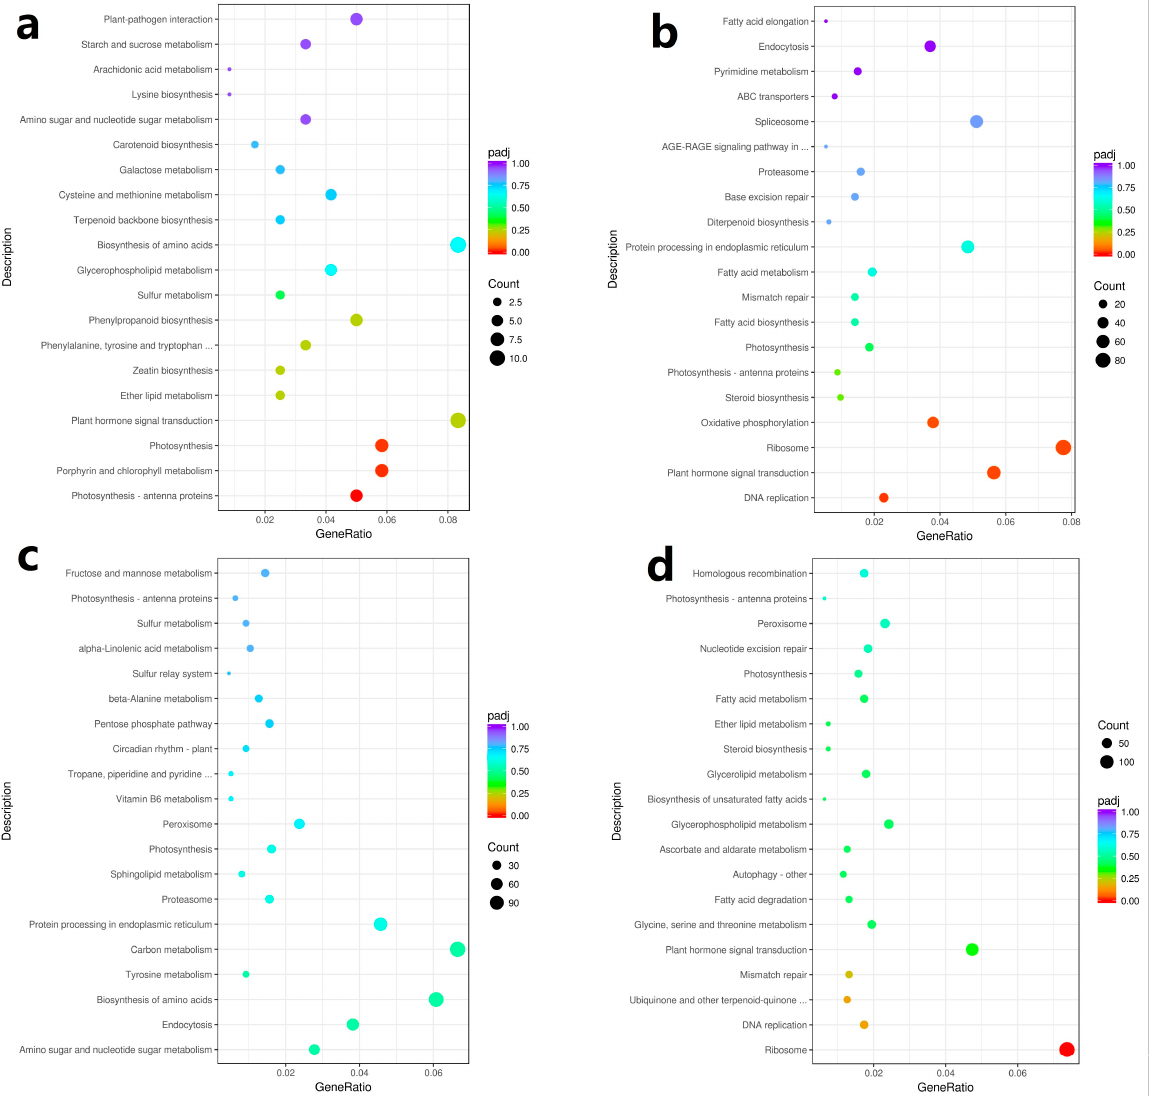
Figure 2. KEGG pathway analysis of mixed flower bud in pre- and post-winter chestnut. According to the results of DEGs, the KEGG pathway is enriched and the bubble diagram is drawn. The abscissa in the figure is the ratio of the number of differential genes annotated to the KEGG pathway to the total number of differential genes, the ordinate is the KEGG pathway, the size of the point represents the number of genes annotated to the KEGG pathway, and the color from red to purple represents the significance of enrichment. ( a ) Two kinds of chestnut mixed flower buds in pre-winter; ( b ) two mixed flower buds of chestnut in post-winter; ( c ) the CMF in pre- and post-winter; ( d ) the IMF in pre- and